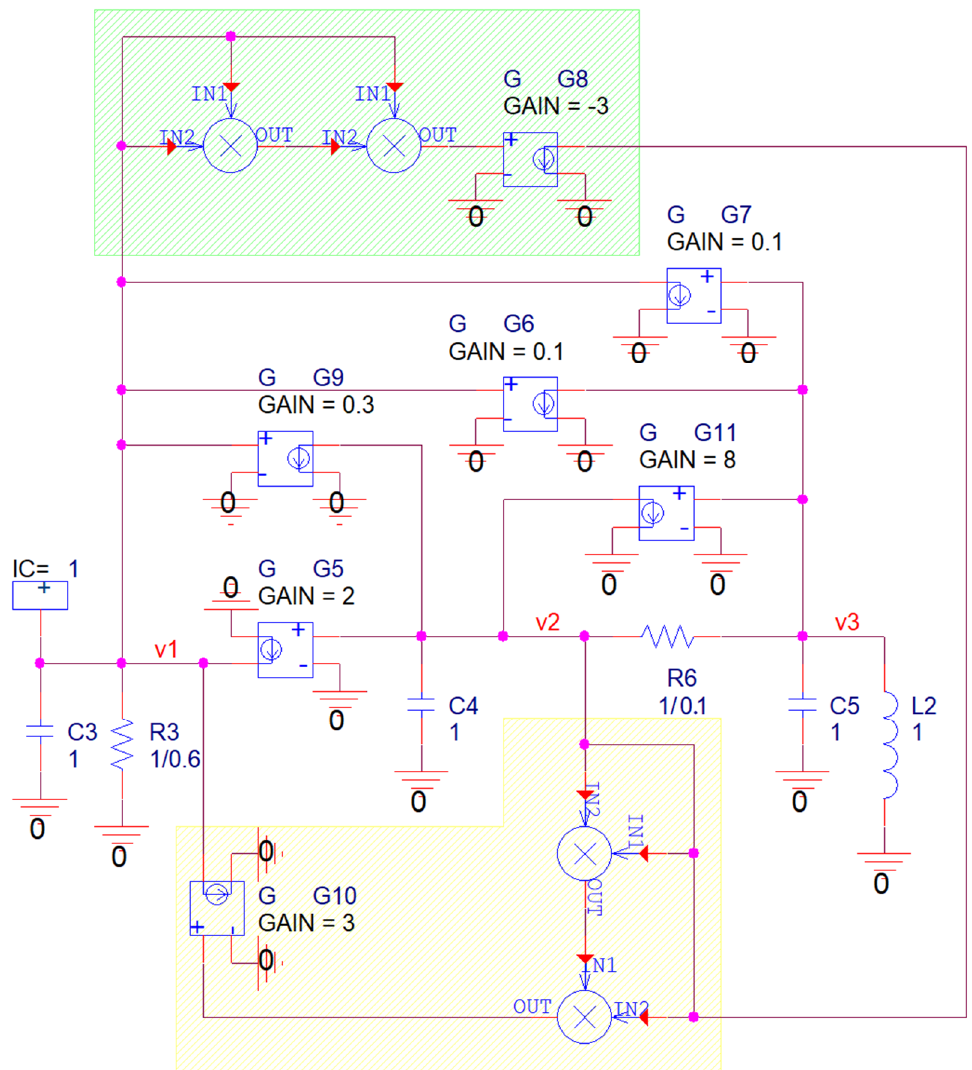
Figure 12. Orcad Pspice simulation results for idealized fourth-order system, circuit realization using pseudo-components MULT and voltage-controlled current-sources G.